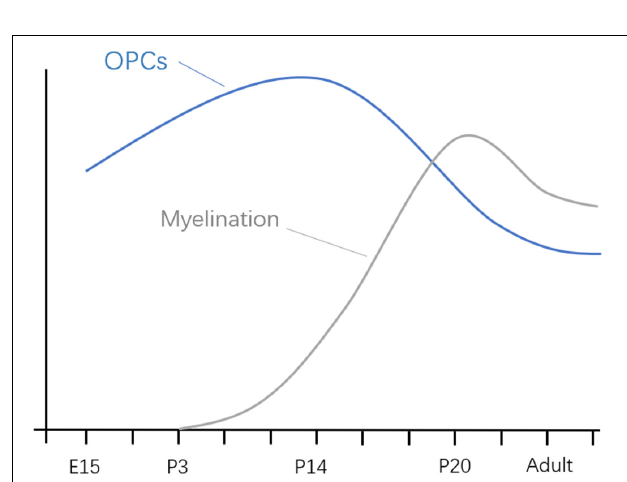
FIGURE 1 | Differentiation, maturation, and myelination of oligodendrocytes. NSC, neural stem cell; OPC, oligodendrocyte precursor cell; OL, oligodendrocyte.